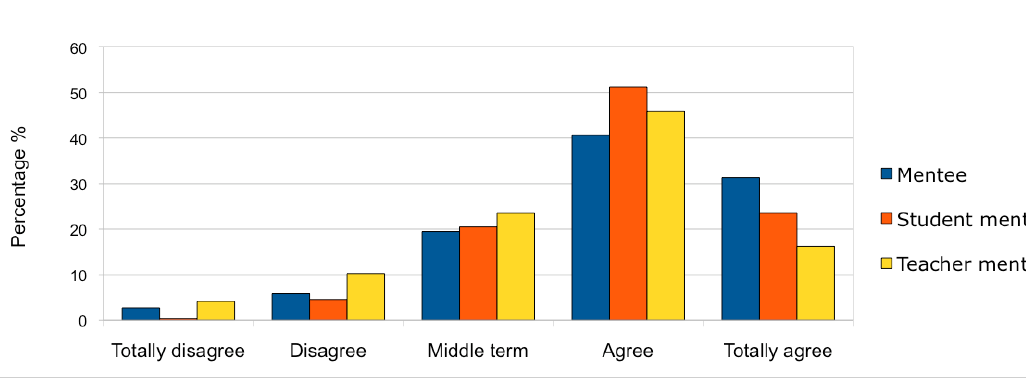
Figure 2. “Have the expectations on the program been